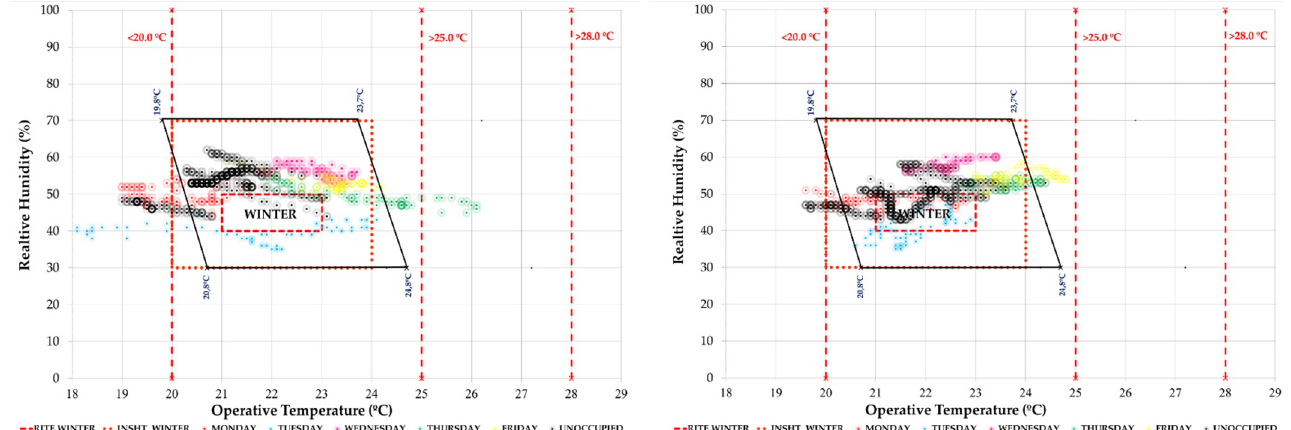
Figure 18. Indoor thermal comfort during the week of 25–31 January 2021 (Phase II) in classroom A 1.1 ( left ) and classroom A 2.1 ( right ). Source: authors.